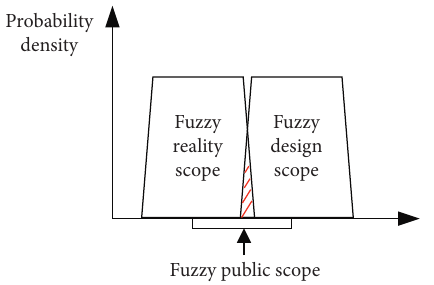
Figure 6: Basic division of housing in the fuzzy axiomatic